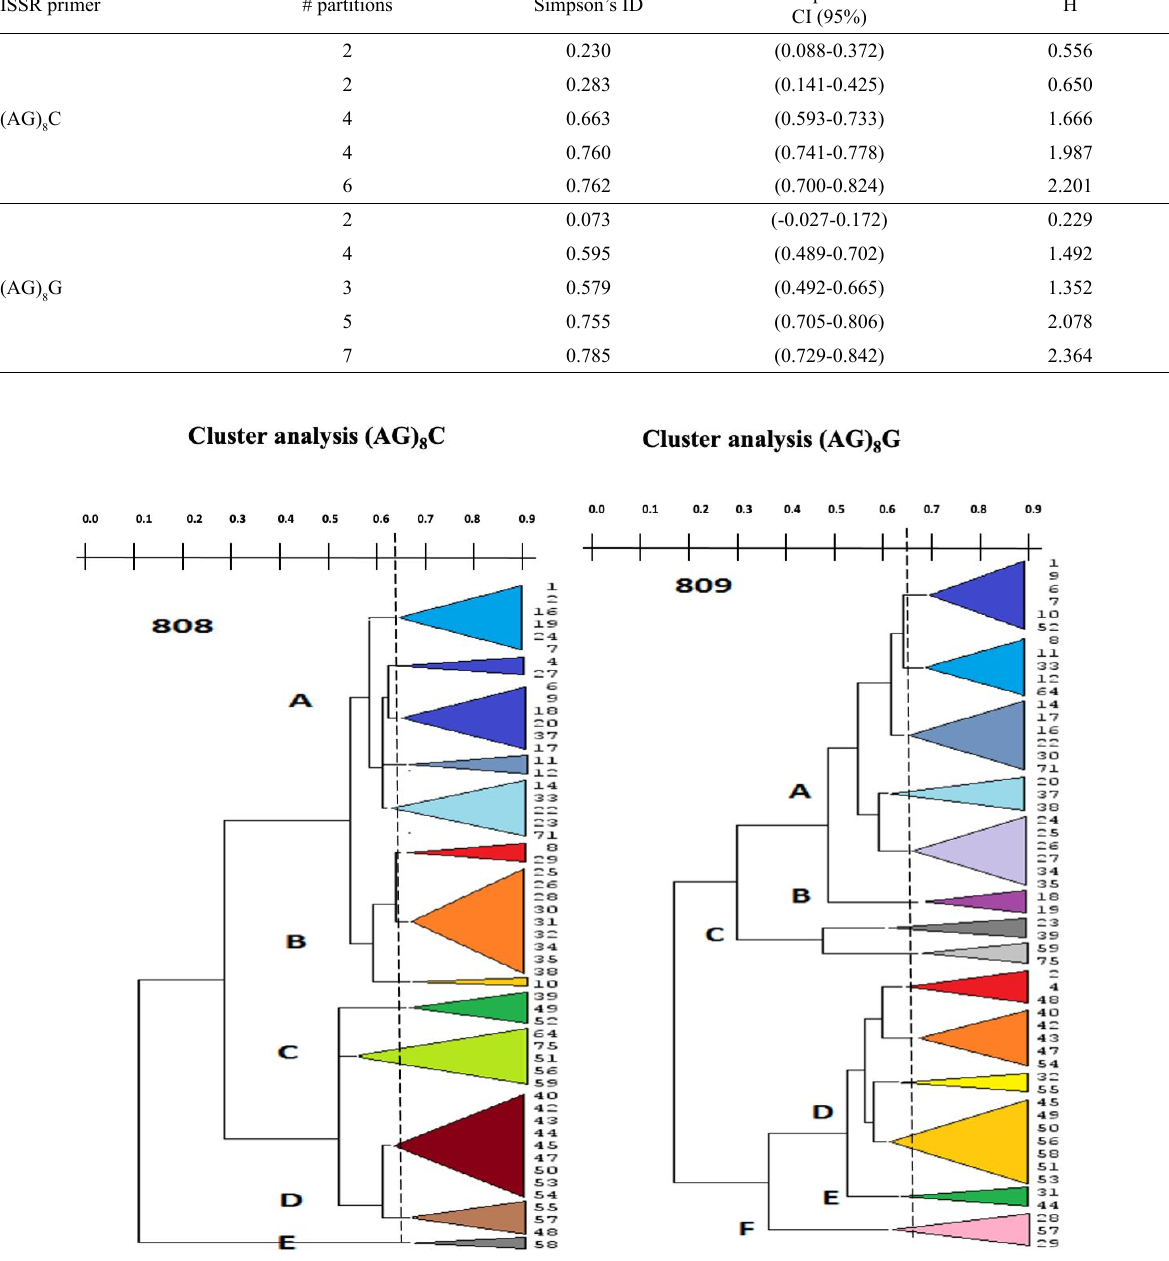
Table 2 – Diversity study of ISSR finger print with Simpson’s index of diversity (SID) and Jackknife pseudo-values. ISSR primer